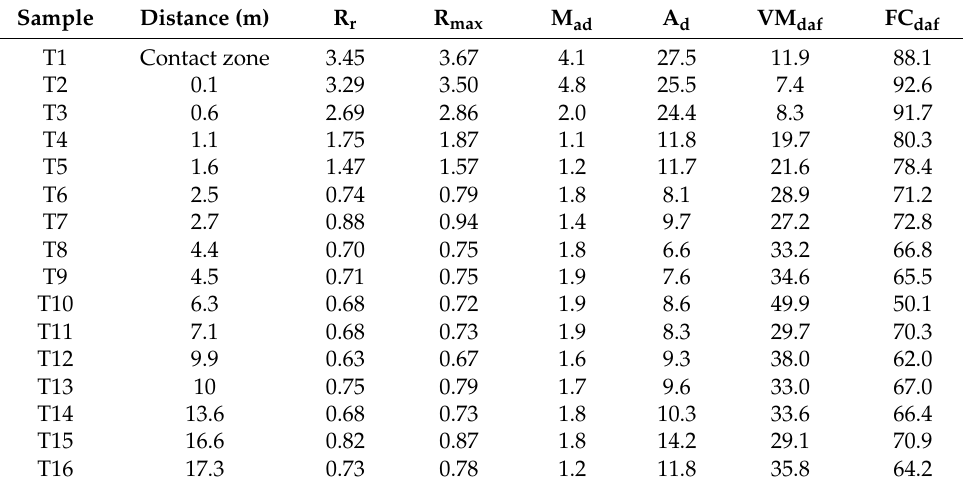
Table 1. The results of the proximate analysis and vitrinite reflectance measurements of the Tashan coal (in %).